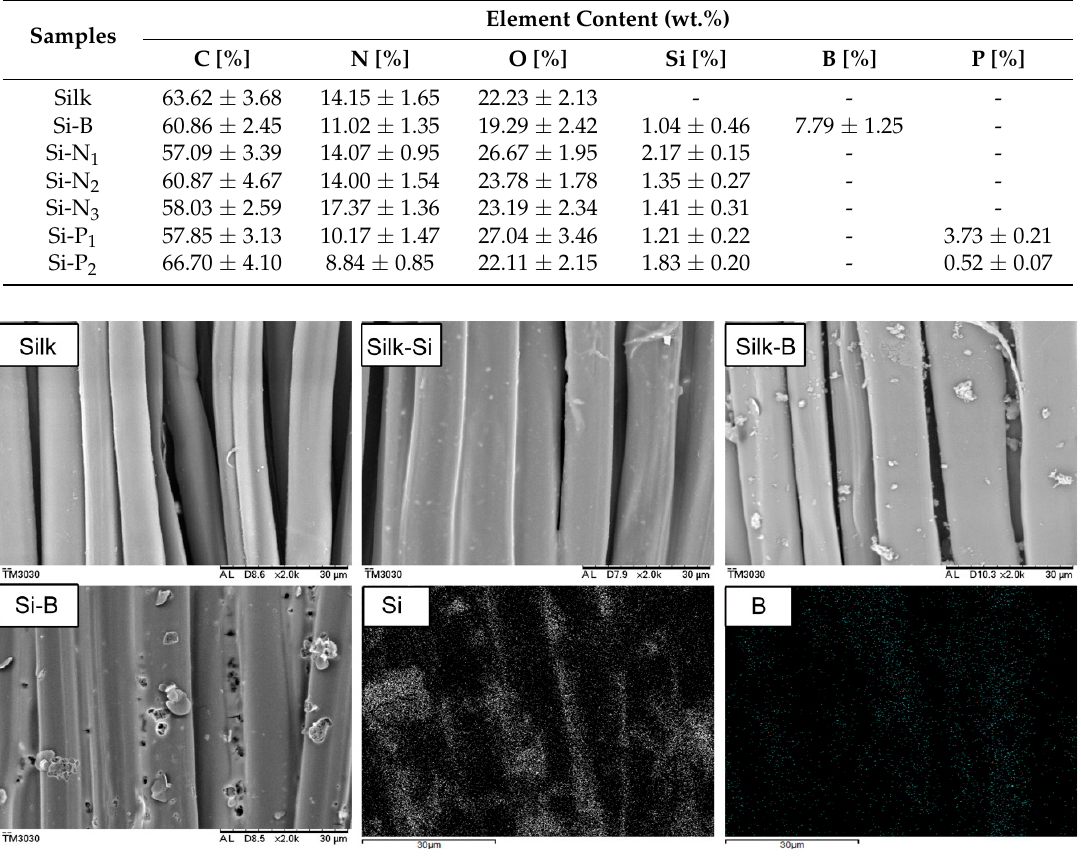
Figure 1. SEM magnifications of Silk, Silk-Si, Silk-B, Si-B samples, and elemental analysis of Si-B sample.